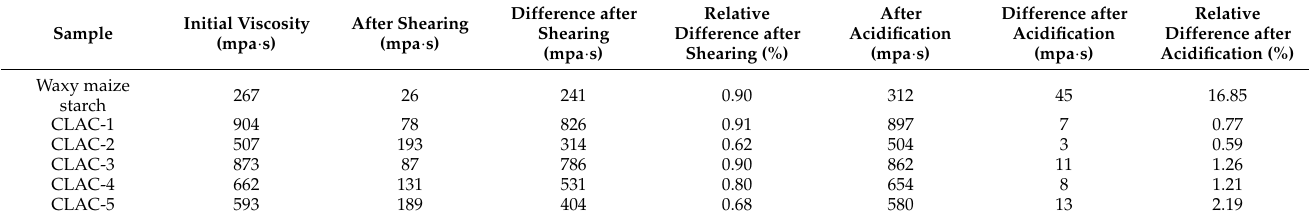
Table 3. Shear tolerance and acid tolerance of waxy native corn starch and cross-linked esterified composite modified starch